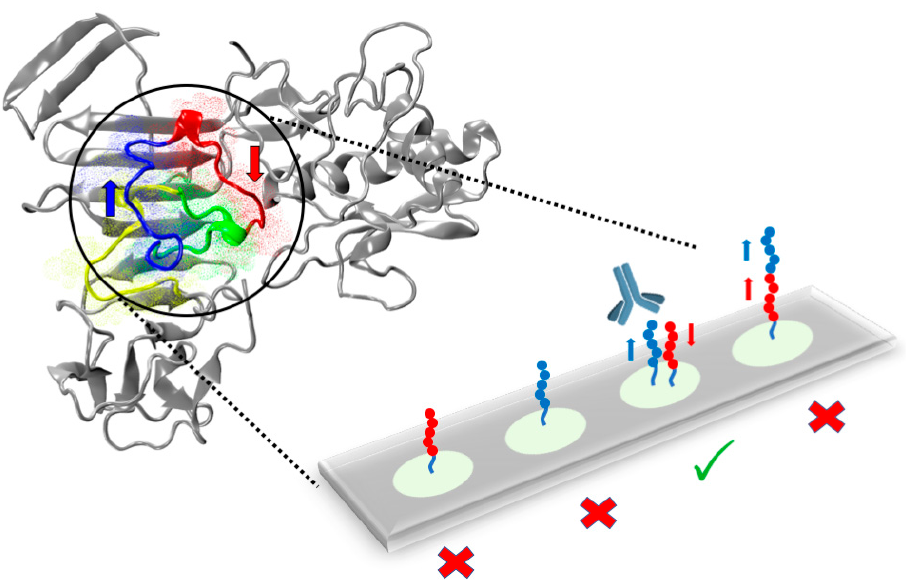
Figure 4. Strategy for the functional mimicking of discontinuous epitopes by the oriented and spatially controlled co-immobilization of proximal peptide sequences forming the putative antigenic region within the native antigen fold.